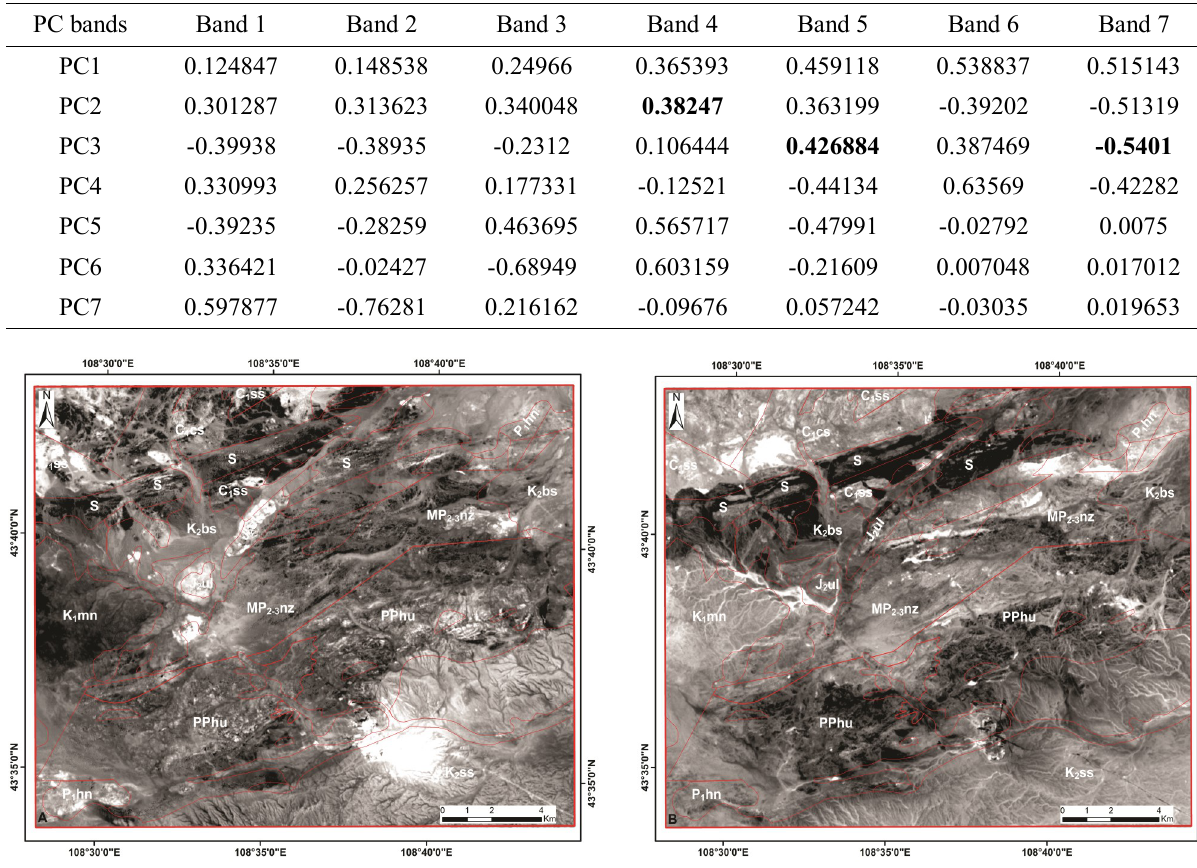
Table 3. The characteristics of spectral bands of Landsat 8 OLI and